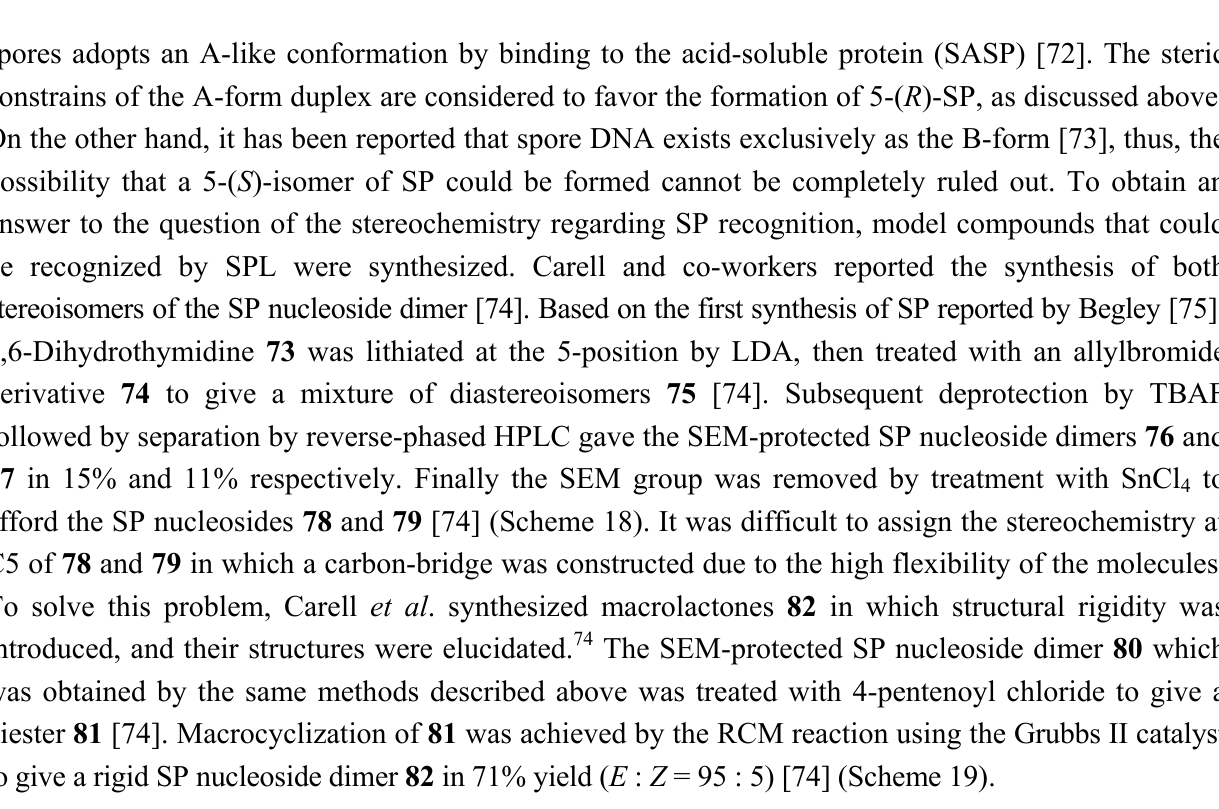
Scheme 18. Synthesis of the SP nucleoside dimer.